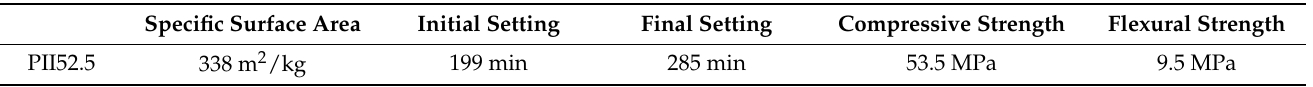
Table 2. Physical properties of Portland cement.